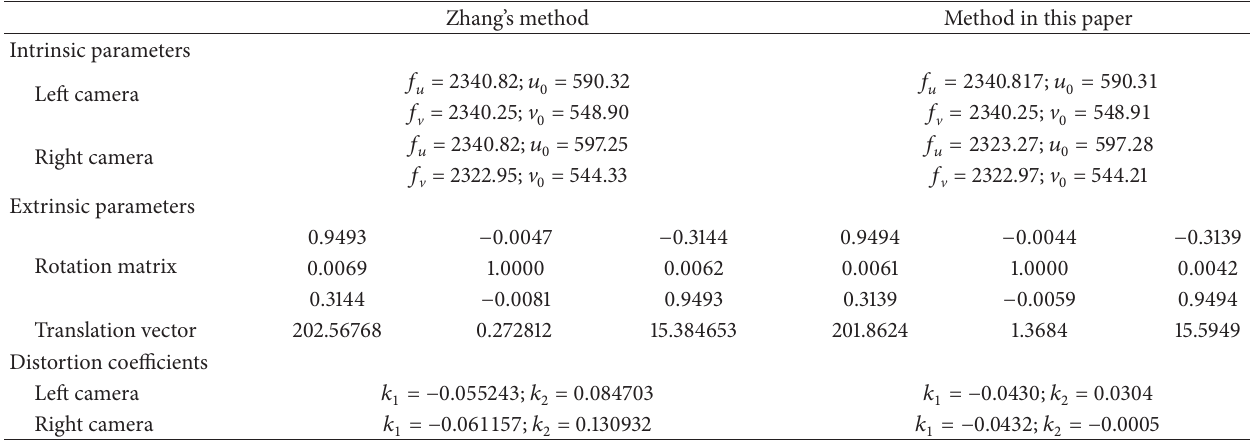
Table 2: Calibration results of Zhang’s method and the proposed method (image number = 10). Zhang’s method Method in this